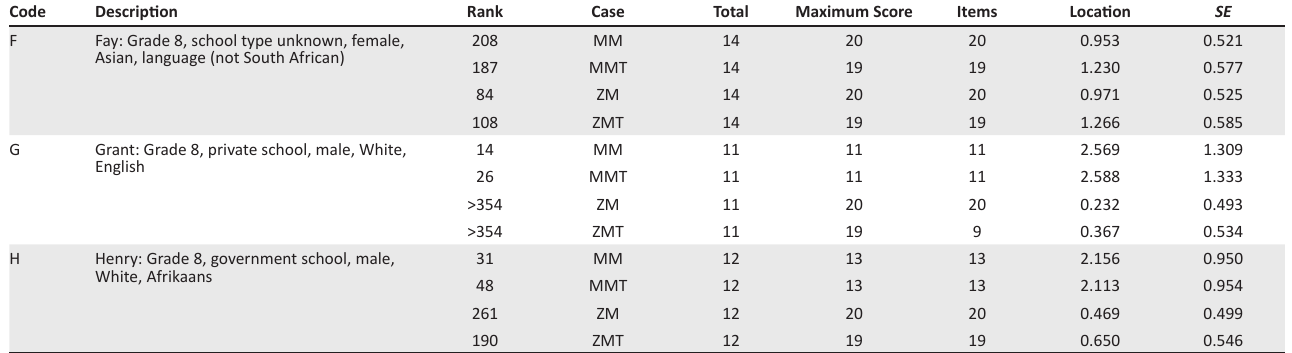
TABLE 12: Comparison of three individuals, selected in top 100 under some criterion. Code